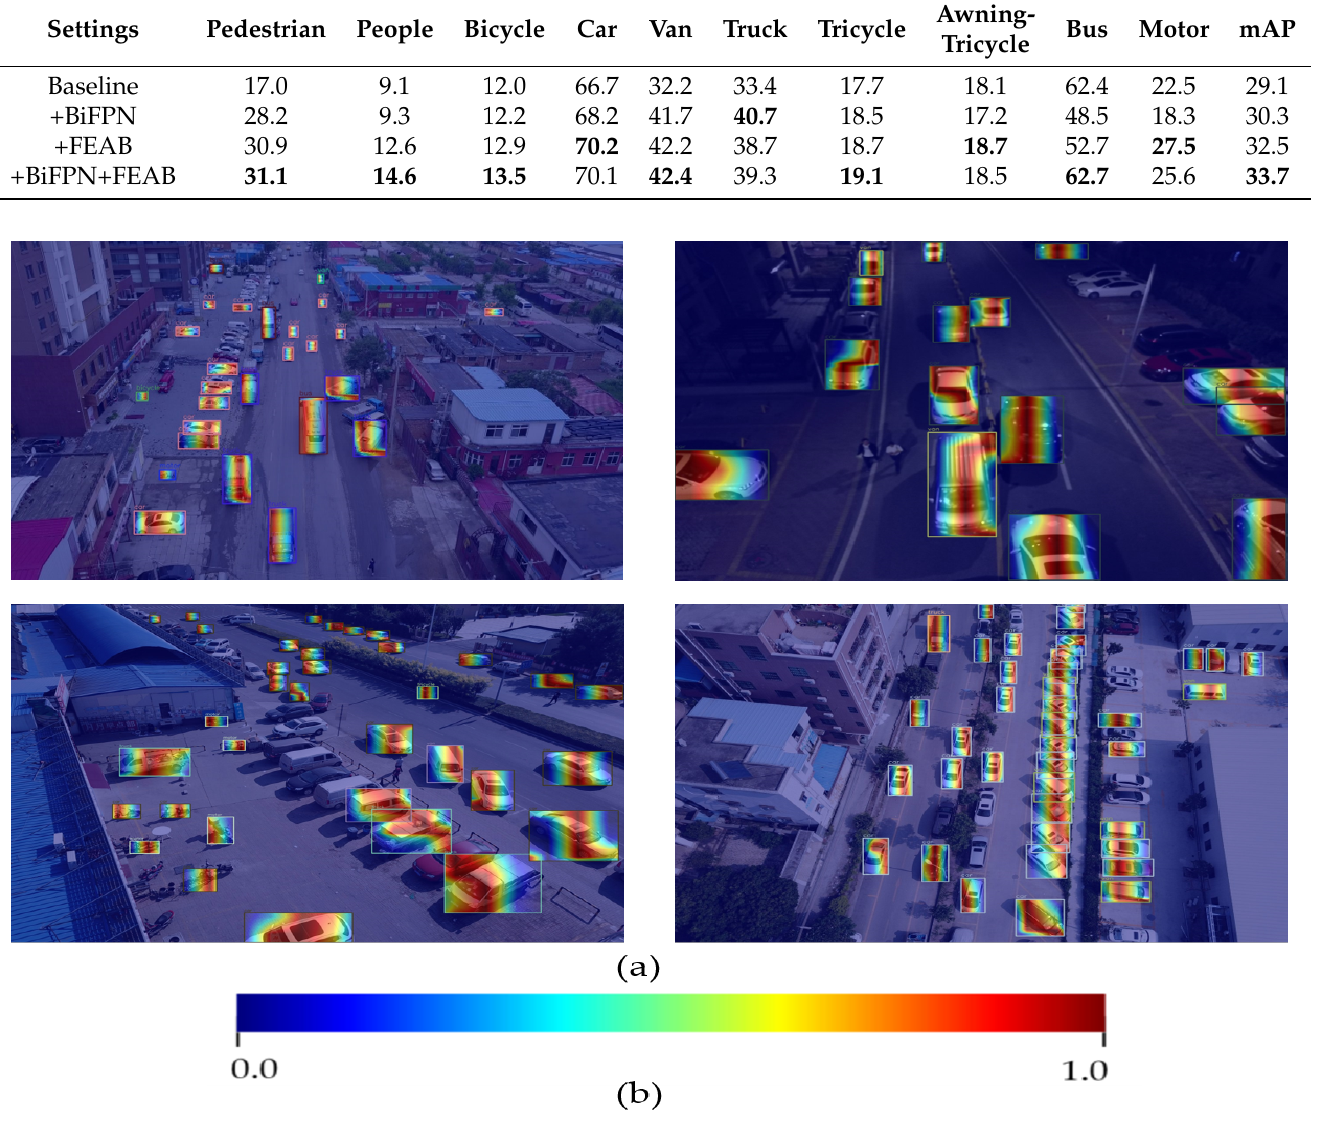
Figure 13. ( a ) A selection of class activation maps (with bounding boxes) exported using grad-cam. ( b ) A color tape corresponding to the model’s degree of focus. The redder the color, the more concern it holds; bluer the color, the less concern it